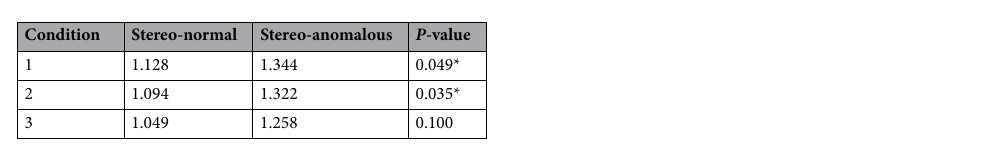
Table 6. Kruskal–Wallis mean comparisons between group and condition for PPR d’ values.